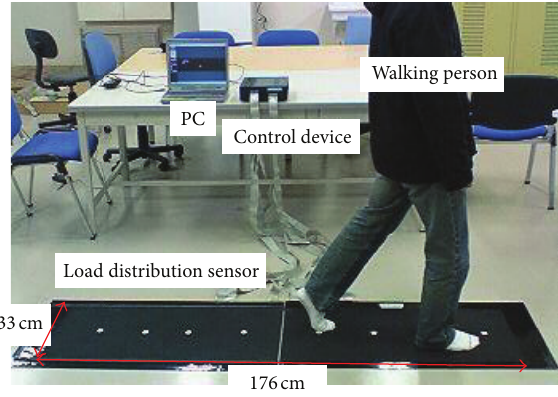
Figure 1: Overview of the data acquisition system.